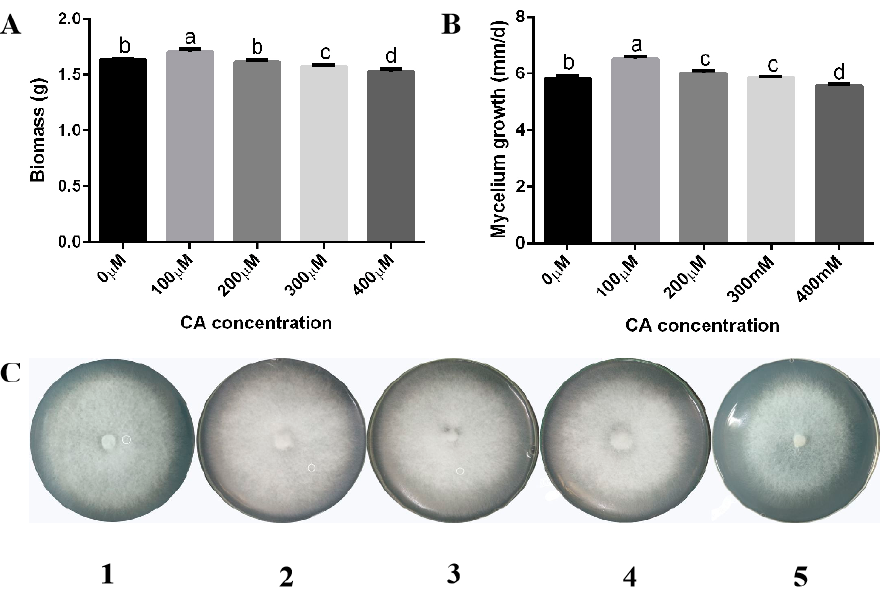
Figure 1. Effects of citric acid on biomass and growth rate of Flammulina filiformis mycelia. ( A ) The content of biomass induced by different concentrations of citric acid was detected in WT strain of F. filiformis . Different letters indicate a significant difference between treatment groups ( p < 0.05). ( B ) A statistical graph of the growth rate of the flat hyphae. Different letters indicate a significant difference between treatment groups ( p < 0.05). ( C ) 1–5 represent the growth state of F. filiformis flat hyphae after addition of citric acid content of 0, 100, 200, 300, and 400 μ M, respectively.